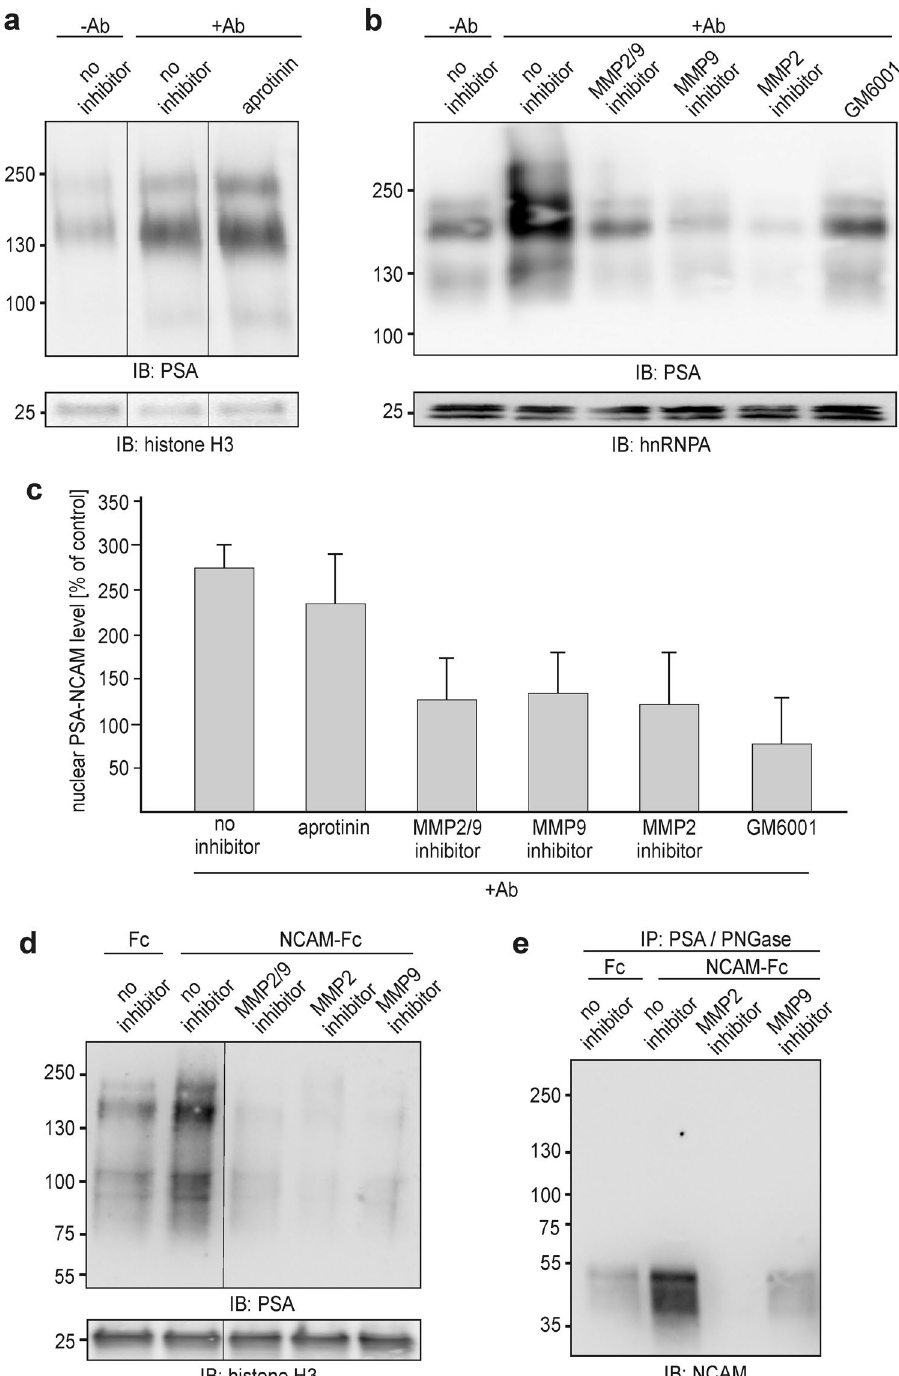
Figure 1. Generation and nuclear import of the PSA-carrying NCAM fragment depends on metalloproteases. ( a – e ) Wild-type cerebellar neurons were pre-treated without (no inhibitor) or with aprotinin (1 µ M), GM6001 (100 nM), and MMP2 inhibitor (25 nM), MMP9 inhibitor (10 nM) or MMP2/MMP9 inhibitor (MMP2/9) (100 µ M) and then incubated without ( − Ab) and with chicken NCAM antibody (12.5 µ g/ml IgY) ( + Ab) ( a – c ) or with NCAM-Fc (10 µ g/ml) or Fc (2 µ g/ml) ( d , e ). Nuclear fractions were subjected to immunoblot (IB) analysis with the PSA antibody or with histone H3 or hnRNPA antibody to control for loading ( a , b , d ) or to immunoprecipitation (IP) with PSA antibody, treatment of the PSA immunoprecipitates with PNGase F and immunoblot analysis of the N-deglycosylated proteins with a rabbit antibody against the extracellular NCAM domain ( e ). ( a , b , d , e ) Representative immunoblots out of three experiments are shown. Lanes that were not adjacent to each other but derived from the same blot are indicated by dividing lines. ( c ) Nuclear PSA levels were quantified by densitometry and normalized to the histone H3 levels. Mean values with standard deviation from 3 independent experiments are shown for the PSA levels relative to the PSA level of non-treated cells (set to